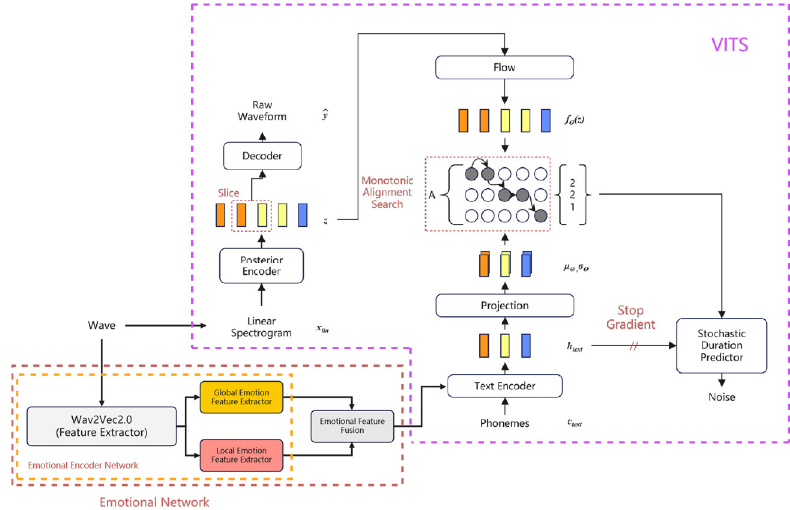
Figure 3. Training procedure of Emo-VITS.